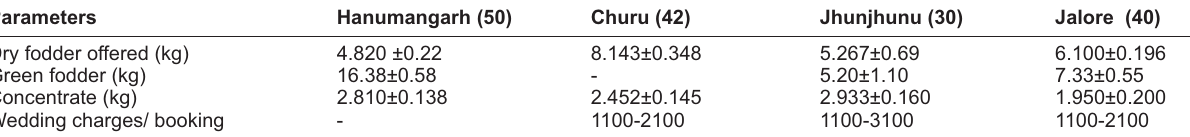
Table-2. The quantity of feed and fodder offered to horses in Rajasthan